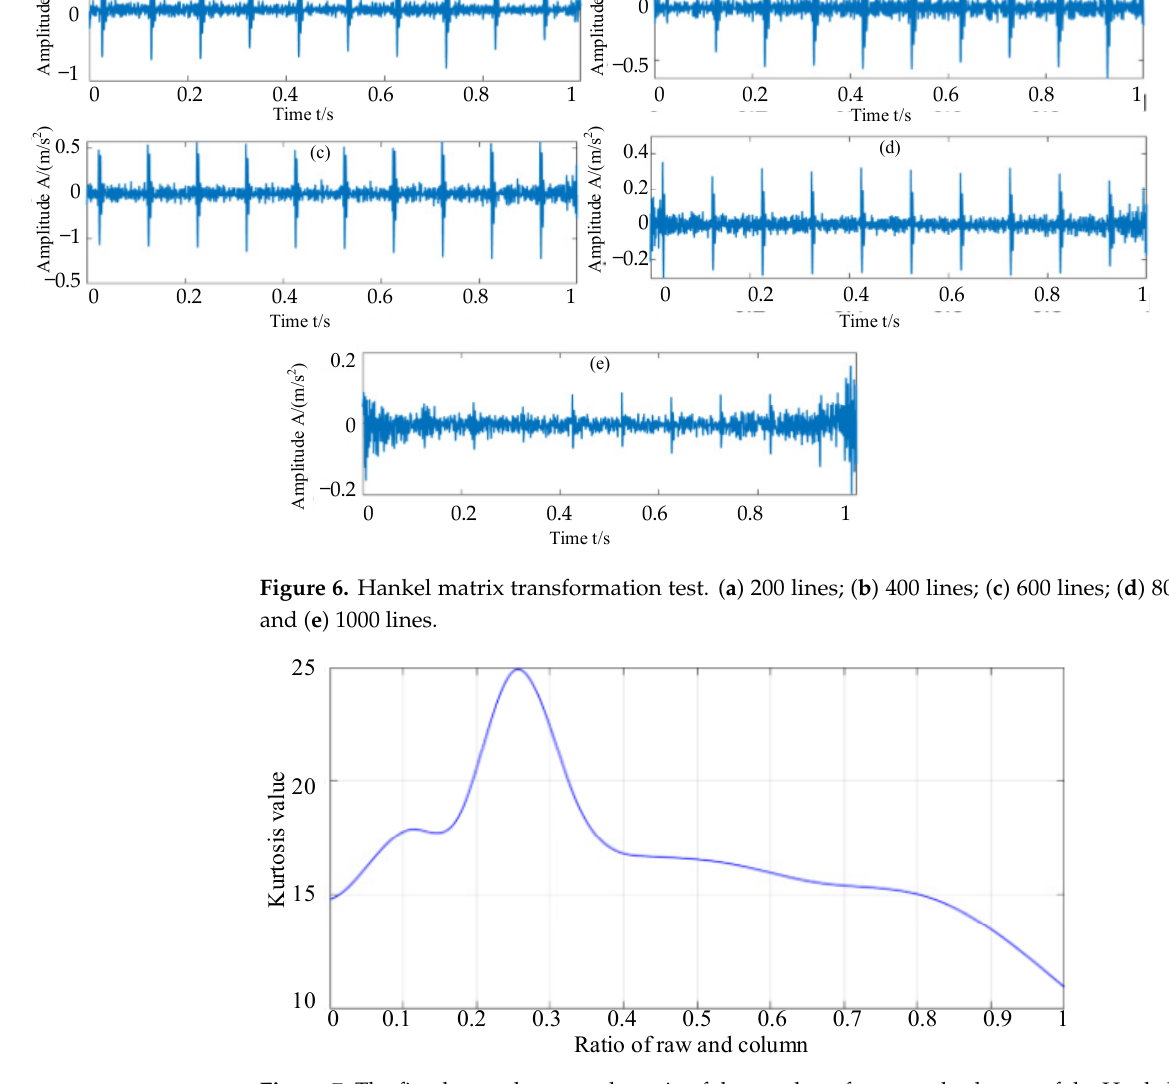
Figure 7. The fitted curve between the ratio of the number of rows and columns of the Hankel matrix and the kurtosis value. Table 4. Running results of K-SVD denoising with different row and column numbers of Hankel matrix.